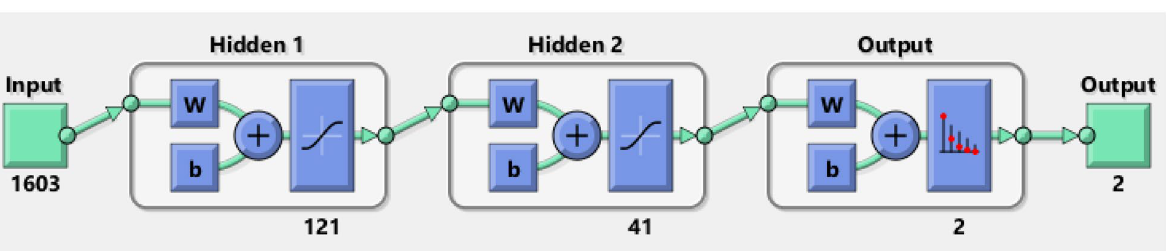
Figure 5. Structure of the two-layer pattern classifier of the second